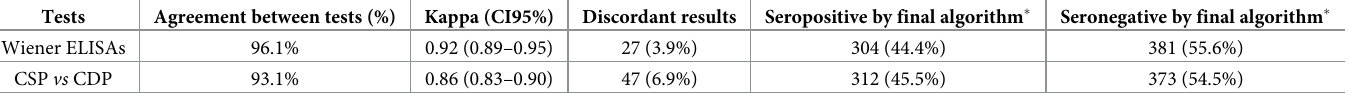
Table 2. Performance of the algorithms based on ELISAs or RDTs for the diagnosis of chronic Chagas disease.